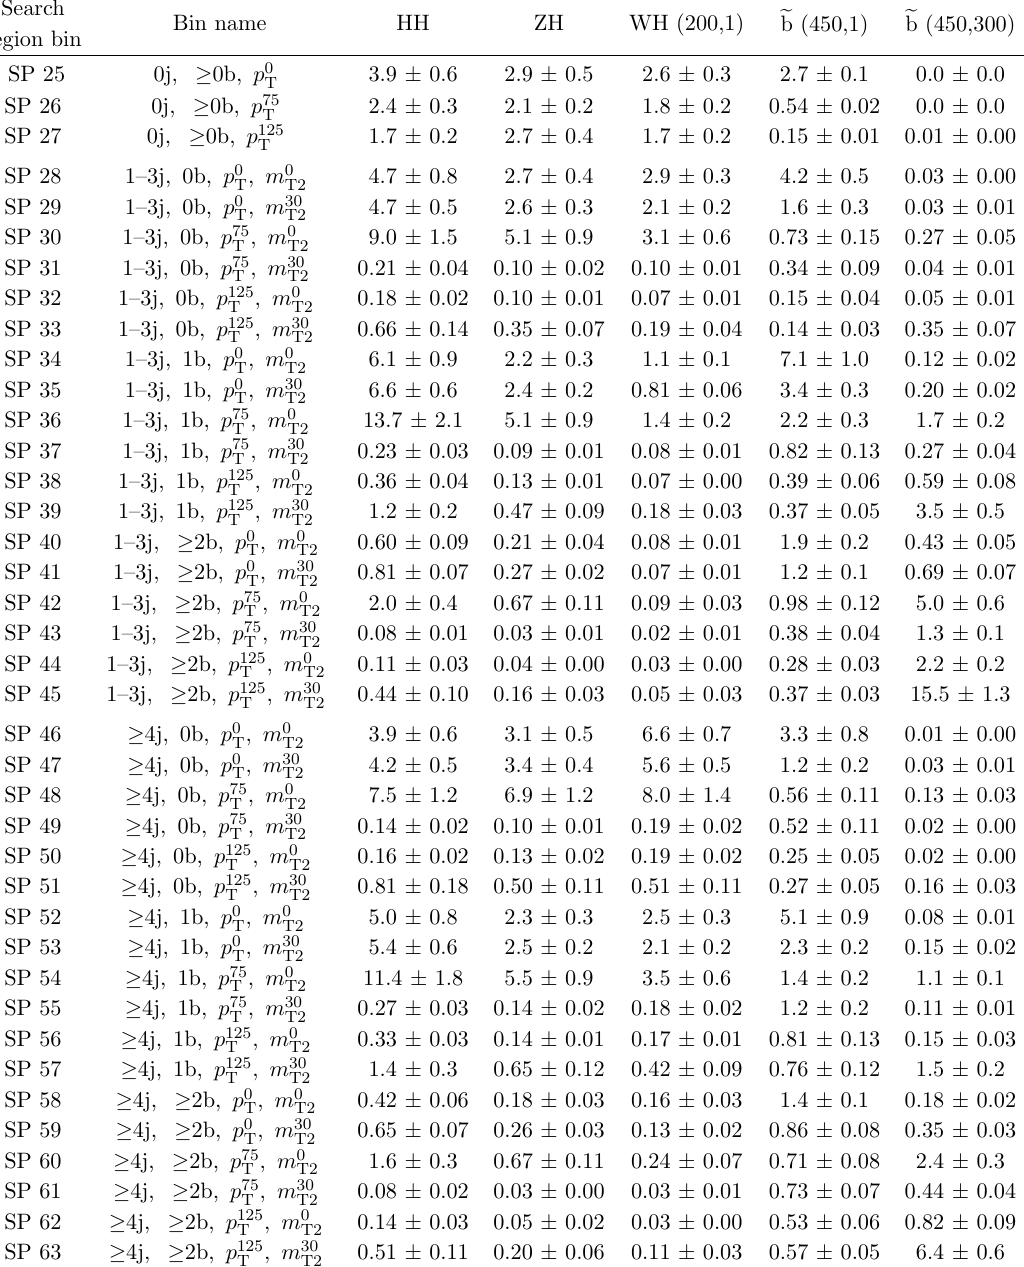
Table 9 . The expected signal yields for the SUSY simpli(cid:12)ed model signals considered are shown for each search region bin in the all-hadronic categories of the SP analysis. The bin names give a short-form description of the search region bin de(cid:12)nition which are given in full in table 3. The labels p 0 , p 75 , and p 125 T T